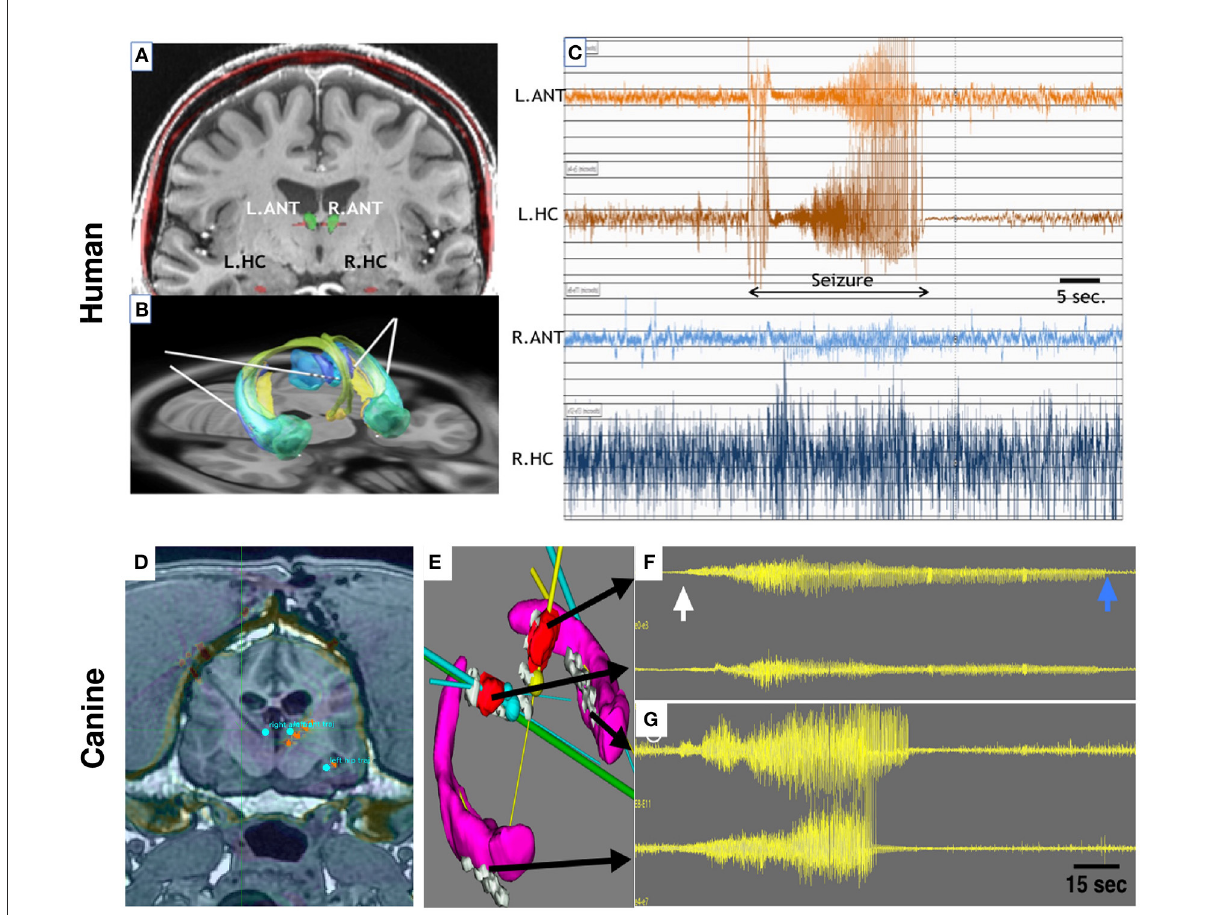
FIGURE2 Bilateral Anterior Nucleus Thalamus (ANT) and Hippocampus (HPC) targets for mesial temporal lobe epilepsy in human (A–C) and canine (D–G ) epilepsy. (A) 3T MRI of a human brain with targets for ANT(green) and HPC (red) electrodes labeled. (B) Papez circuit with ANT (blue) and HPC—AMG (green) targets and implanted electrode leads (white lines). (C) Spontaneous focal seizure with simultaneous left ANT and HPC involvement. Clinically the patient had intense fear and loss of awareness. The seizure has synchronous left ANT and HPC onset without the evolvement of contralateral ANT or HPC. (D) 3T MRI and stereotactic targeting in the canine brain. The bilateral ANT and HPC targets are highlighted. The coronal MRI shows the massive cranial musculature surrounding the canine skull. (E) Bilateral HPC (purple) and ANT (red) target volumes and implanted electrodes (gray). The multiple color straight lines indicate target trajectories for electrode leads. (F,G) Four channels of intracranial EEG. From top to bottom: Left ANT, Right ANT, Left HPC, and Right HPC recordings. The onset of a seizure (white arrow) and the seizure offset (blue arrow) are clearly evident in both HPC and ANT recordings, but interestingly the seizure terminates in all electrodes at different times. The longest seizure discharge is in the left ANT (top trace). See text for details. ANT, anterior nucleus of the thalamus; HPC, hippocampus. Adapted from Sladky et al.